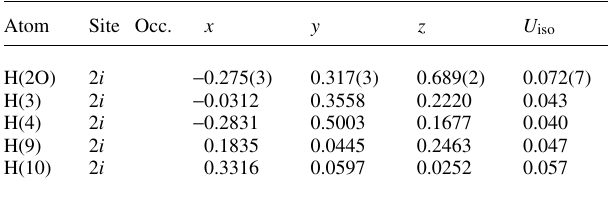
Table 2. Atomic coordinates and displacement parameters (in Å 2 )